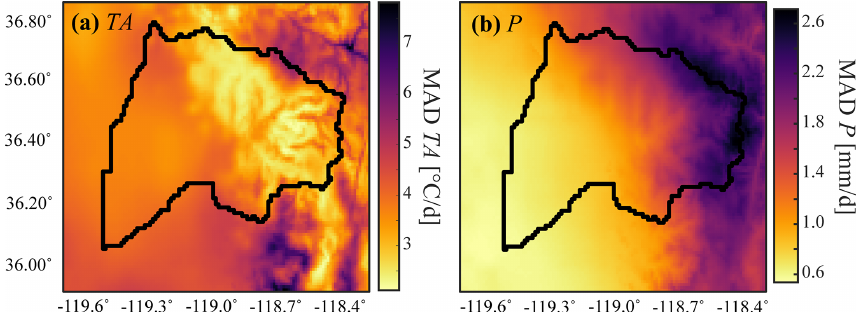
Figure 4. Uncertainty in the daily air temperature (a) and precipitation (b) datasets represented by the mean absolute difference (MAD) for the 3 water years (2011, 2014, and 2016) used in this study.